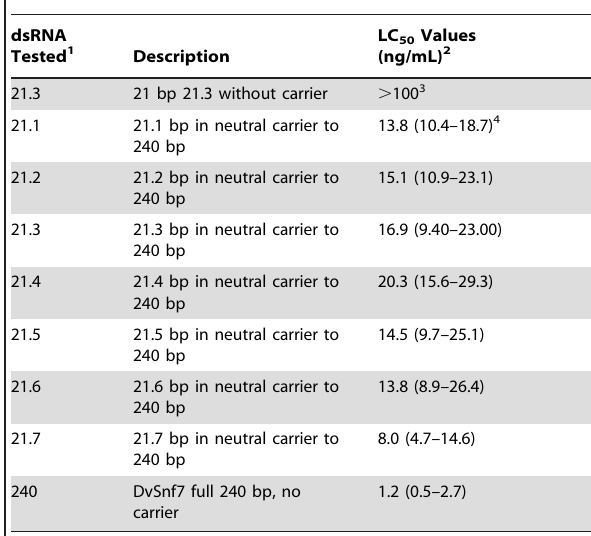
Table 3. Comparison of LC 50 values for siRNA and dsRNAs in 12 day Southern Corn Rootworm, (SCR, Diabrotica undecimpunctata howardi ) diet